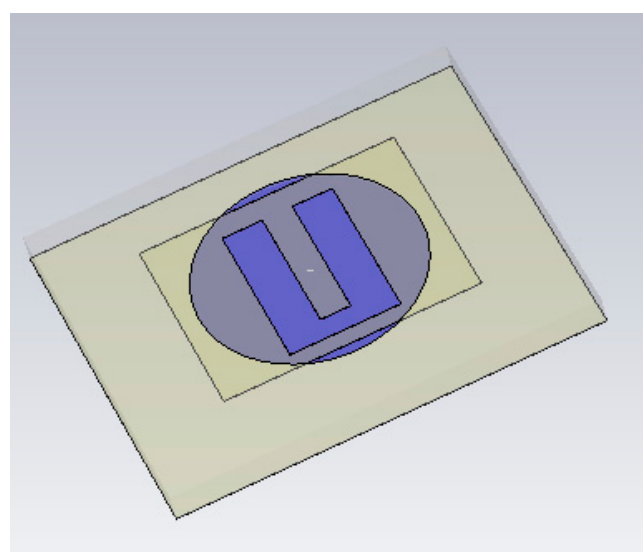
Figure 7. Prototype model in the CST Microwave Studio to analyse the moisture effect. Table 5. Water content used to simulate the moisture effects on different antenna samples. Water Weight.